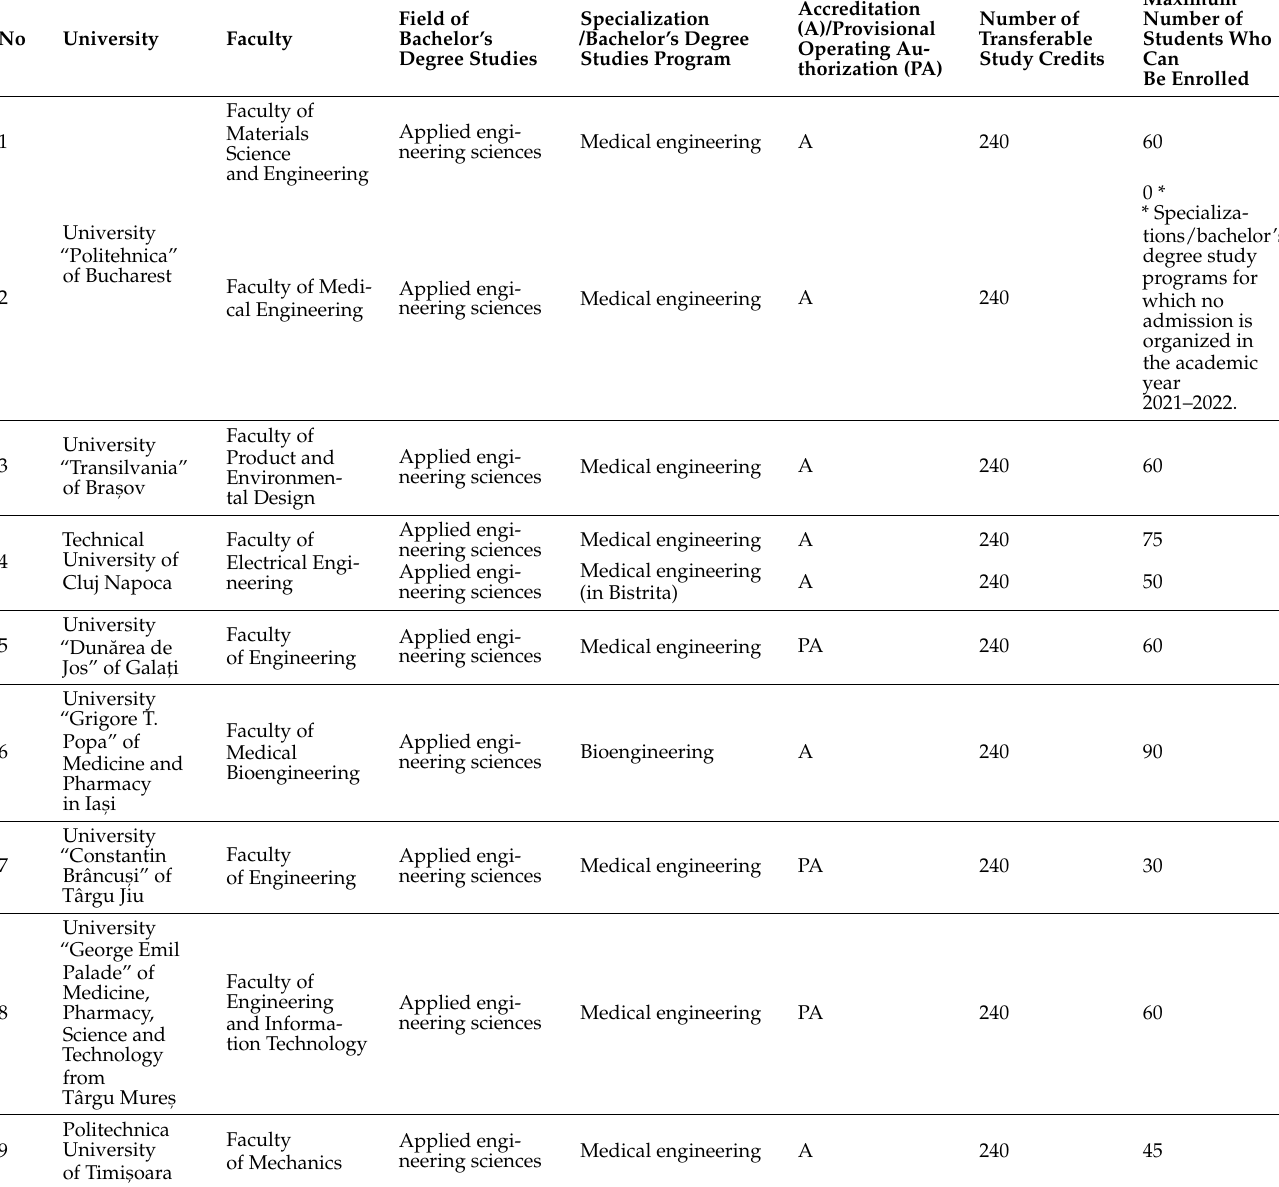
Table 3. B.Sc. level BME specializations in Romania,